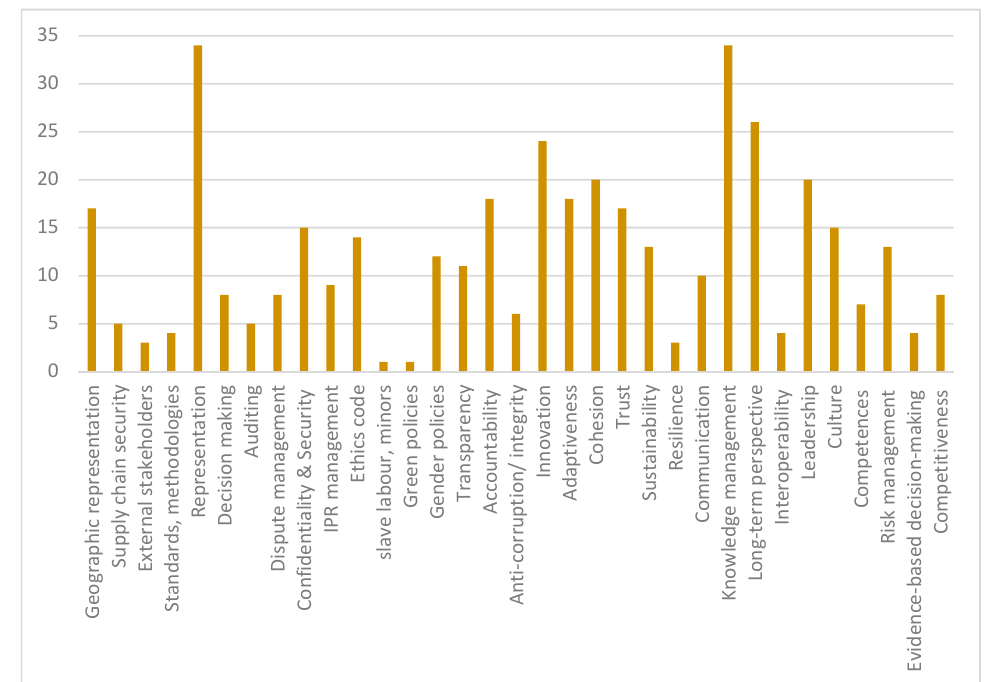
Figure 3. Number of existing networked organisations referencing each governance issue in their statutory